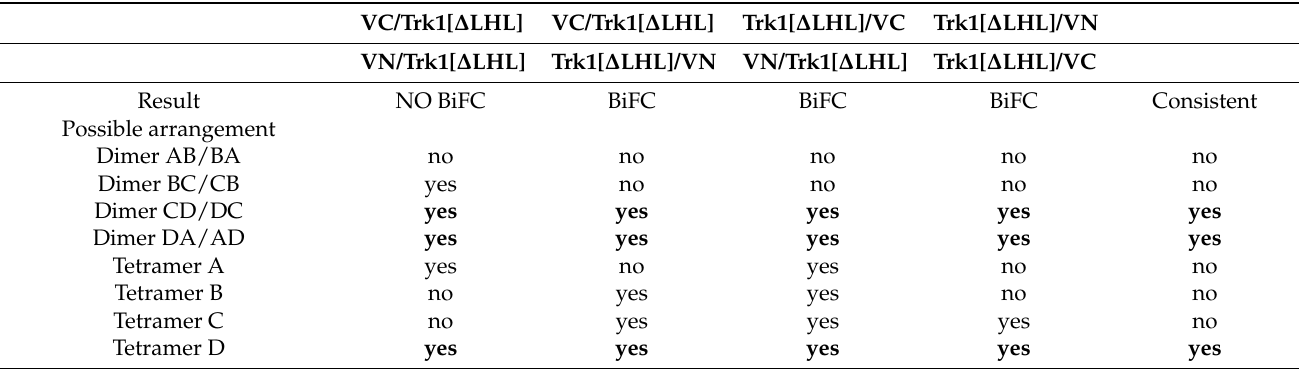
Table 1. From modelling expected (possible) BiFC and observed BiFC with different N- and C- terminal Trk1[ ∆ LHL] fusions with VN and VC.